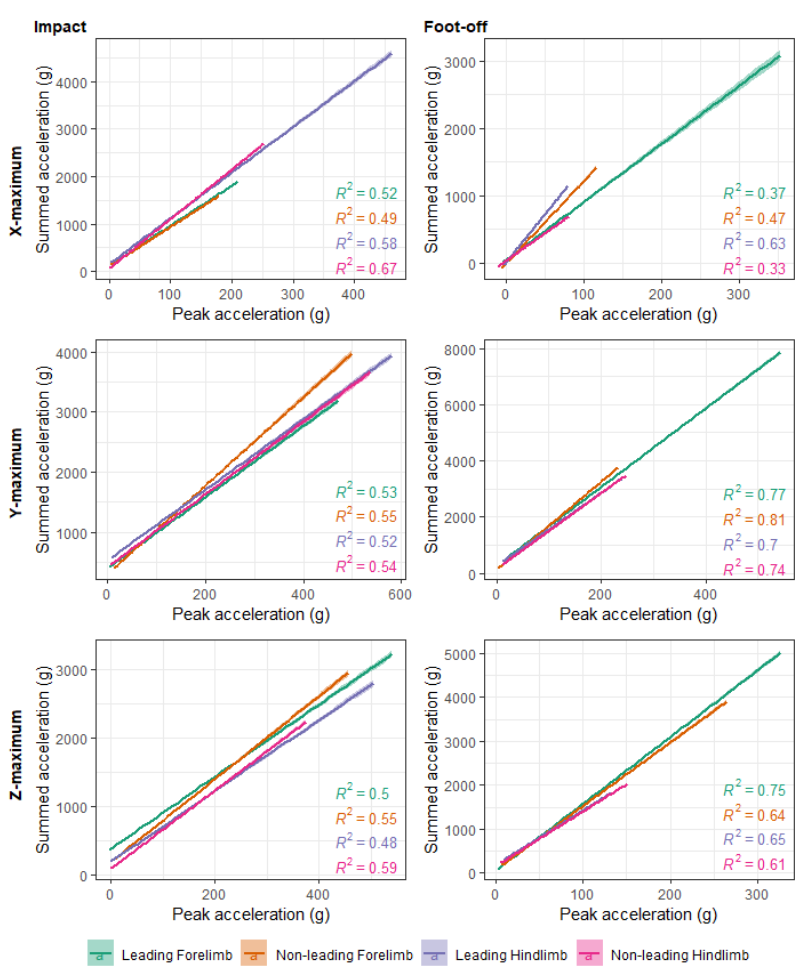
Figure A6. Positive linear relationships between peak accelerations and summed accelerations (positive) within 5 ms forward in time of the maximum peak. Data are subdivided according to acceleration parameter for each limb. All p < 0.001.